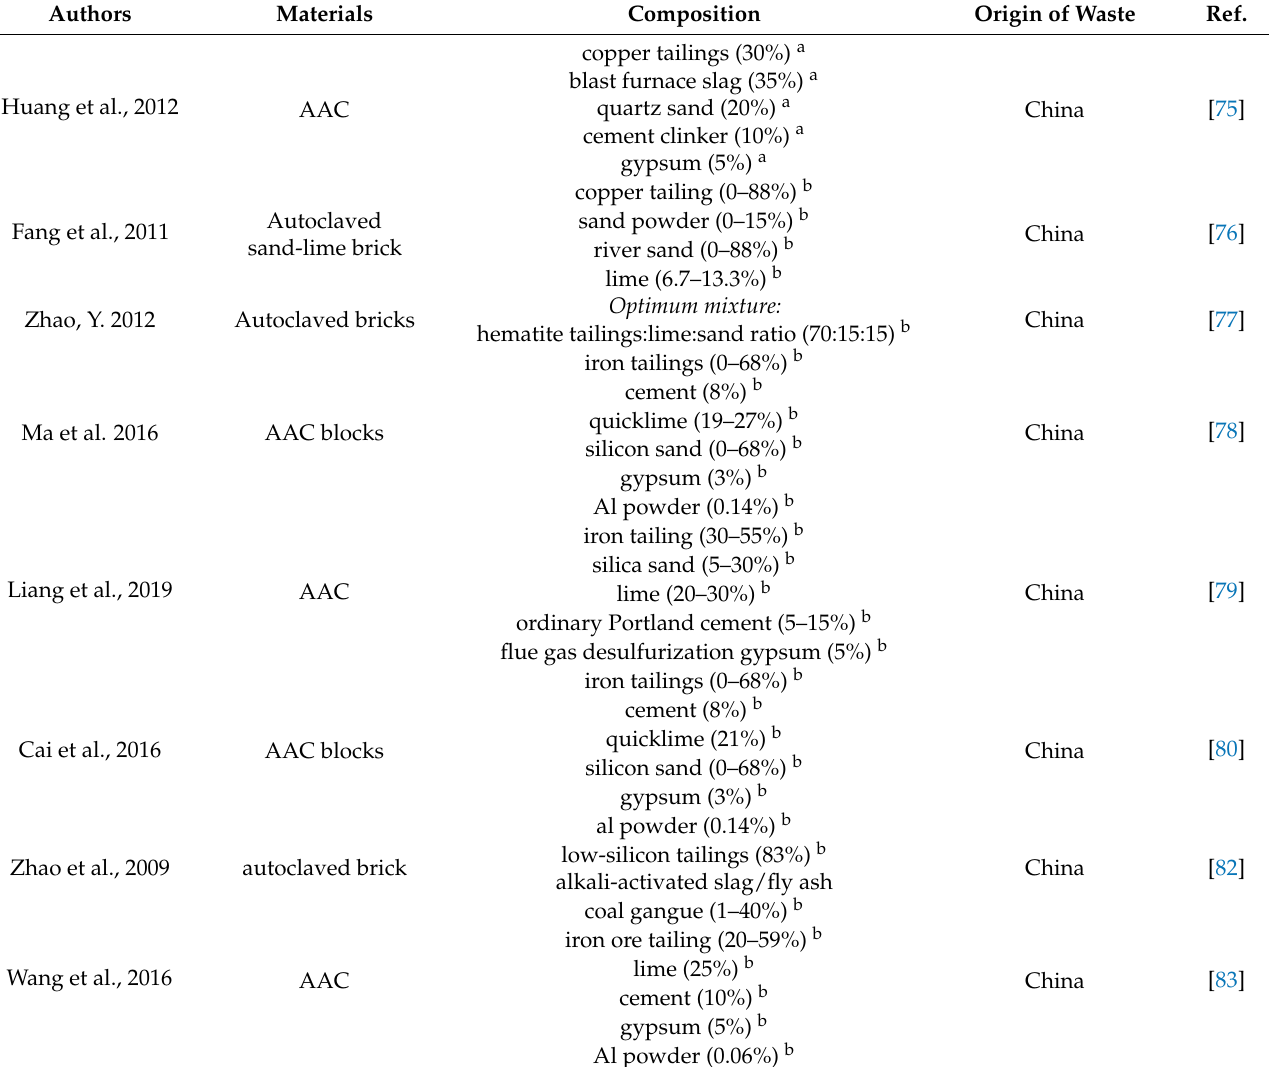
Table 3. Mining waste used for AAC